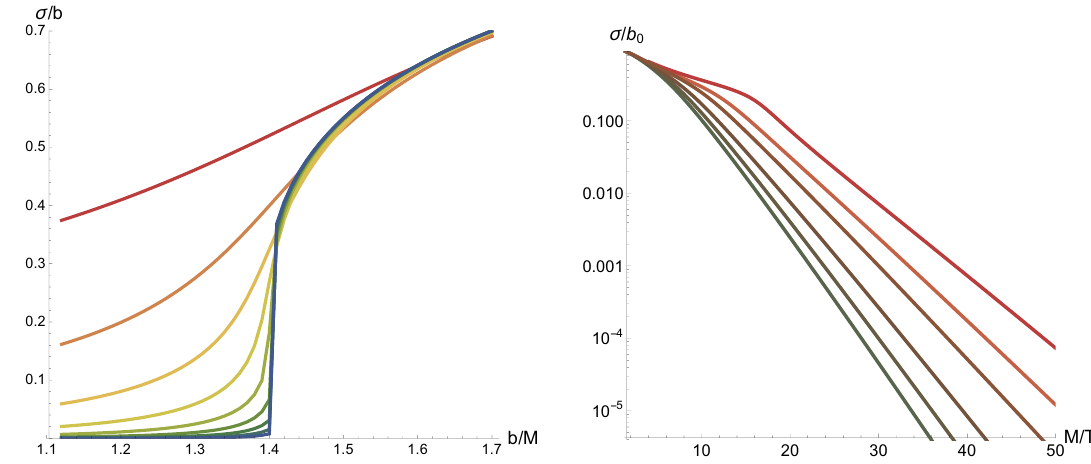
Figure 4 . Left: AHC (cid:27) against (cid:22) b for zero disorder and at (cid:12)nite temperature T=M = 1 =(cid:25) (cid:0) 1 = (10 (cid:25) ) (red-blue). At low enough temperatures (blue) a quantum phase transition occurs. Right: semilogarithmic plot of the AHC (cid:27) vs M=T for (cid:12)xed (cid:22) b = 0 : 9 (cid:0) 1 : 39 (green-red). At high enough M/T we (cid:12)t the curves to a function of the type e (cid:0) cx (cid:11) where x (cid:17) M=T (cid:12)nding (cid:11) = 1 : 05. Close to the phase transition, at (cid:22) b = 1 : 39 (red line), a new scaling appears at low M/T. This is an e(cid:11)ect of the quantum critical region (see (cid:12)gure 5).